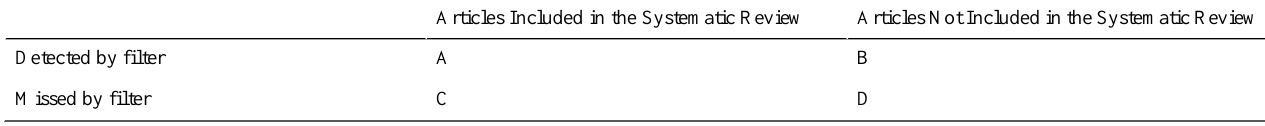
Table 1. A 2x2 table created for each systematic review and formulas used a